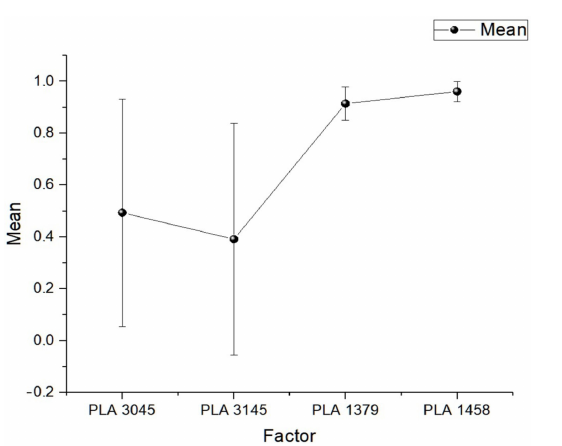
Figure 9. Means Plot SD (as